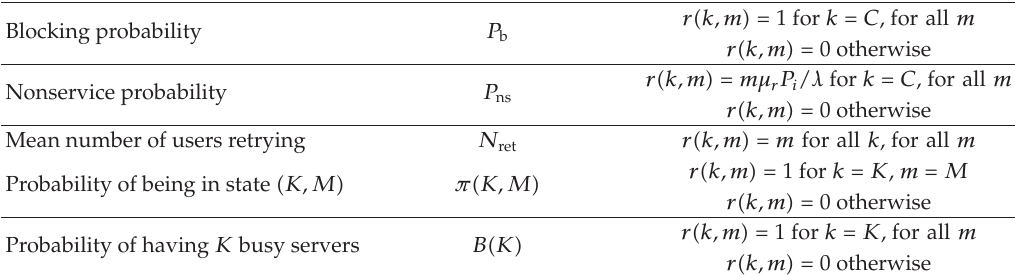
Table 1: Revenue function